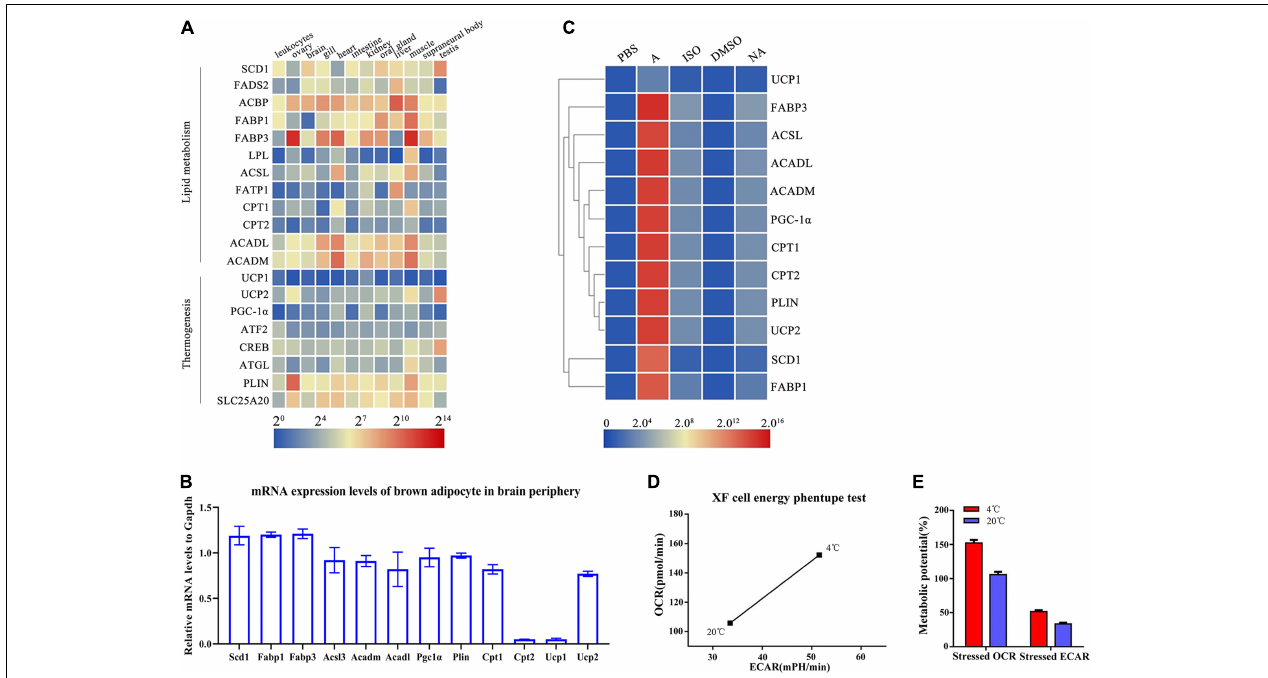
FIGURE 3 | Identification of lamprey brown adipocytes through molecular and functional analysis. (A) Expression profiles of brown adipocyte-enriched markers and key transcription factors in lamprey tissues obtained by real-time PCR. Gapdh expression was used as an internal control. The expression profiles of marker genes are shown in a heat map. Blue and red indicate low and high expression levels. (B) The mRNA expression of selected genes enriched in lamprey brown adipocytes. (C) The lamprey brown adipocytes were treated with adrenaline (1 µ M), isoprenaline (10 µ M) and norepinephrine (0.5 µ M) for 24 h at 18 ◦ C. Expression analysis of enriched markers and key transcription factors was performed using real-time PCR. All of the data are presented as the means ± SDs based on three independent cDNA samples with three replicates per sample. (D) Metabolic profile of the stimulatory effect of temperature on oxidative phosphorylation and glycolysis. (E) The stressed OCRs and ECARs of glycolysis and oxidative phosphorylation. Each bar represents the mean value from three determinations with the standard deviation